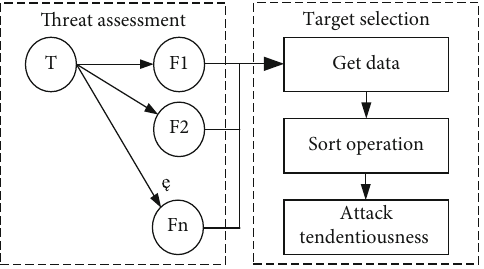
Figure 6: Attack tendency feature extraction process. F 1 -Fn represents our di ff erent fi ghters, and T represents the enemy fi ghter. The threat assessment value of each aircraft to the target is obtained through the data link. Then, rank these evaluation values to get the enemy ’ s attack tendency.